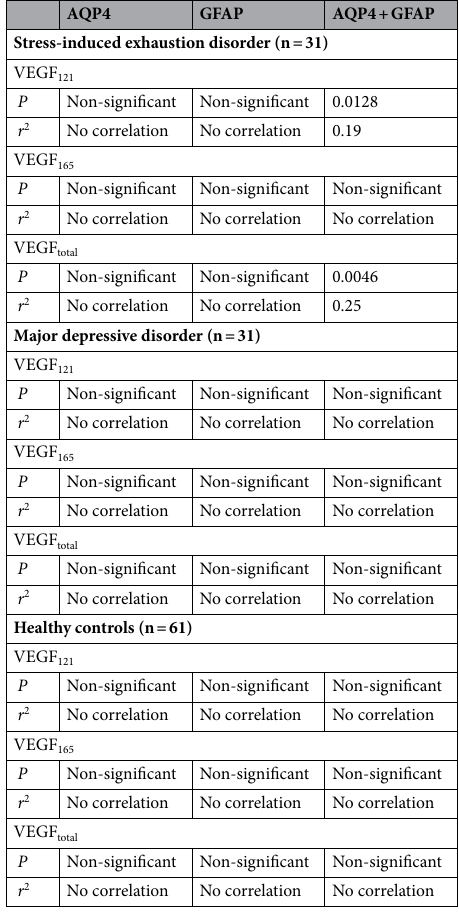
Table 3. Correlation between levels of vascular endothelial growth factor (VEGF) isoforms and astrocyte- derived extracellular vesicles, including aquaporin-4 (AQP4), glial fibrillary acidic protein (GFAP),